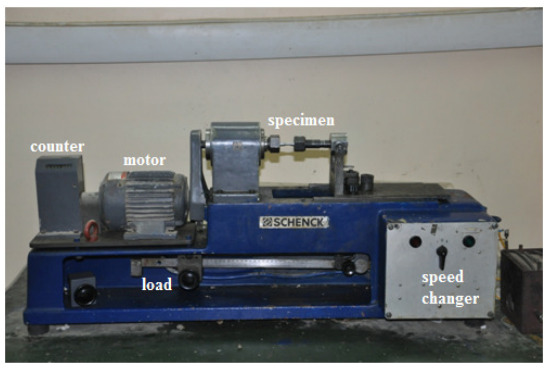
Fig. 3. Fatigue bending machine test Schenck.